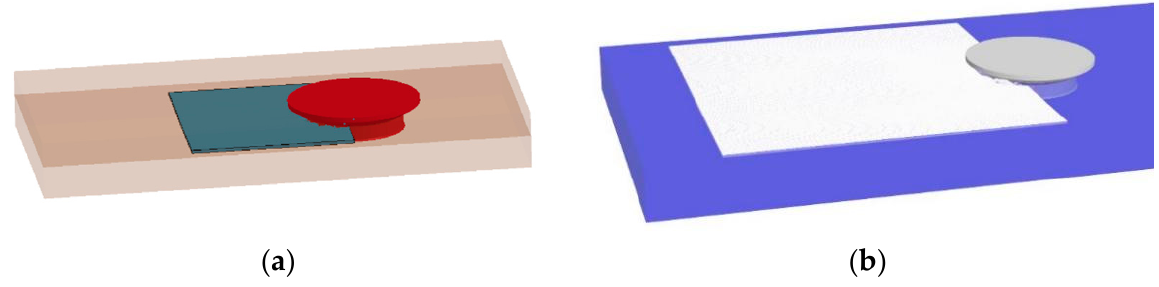
Figure 6. Numerical calculation of interaction between ice and structures. ( a ) Finite element method; ( b ) Discrete element method.